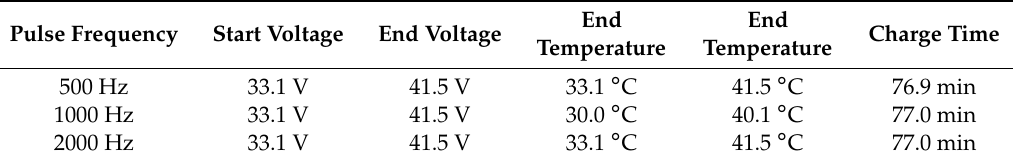
Table 3. Experimental results by pulse frequency.